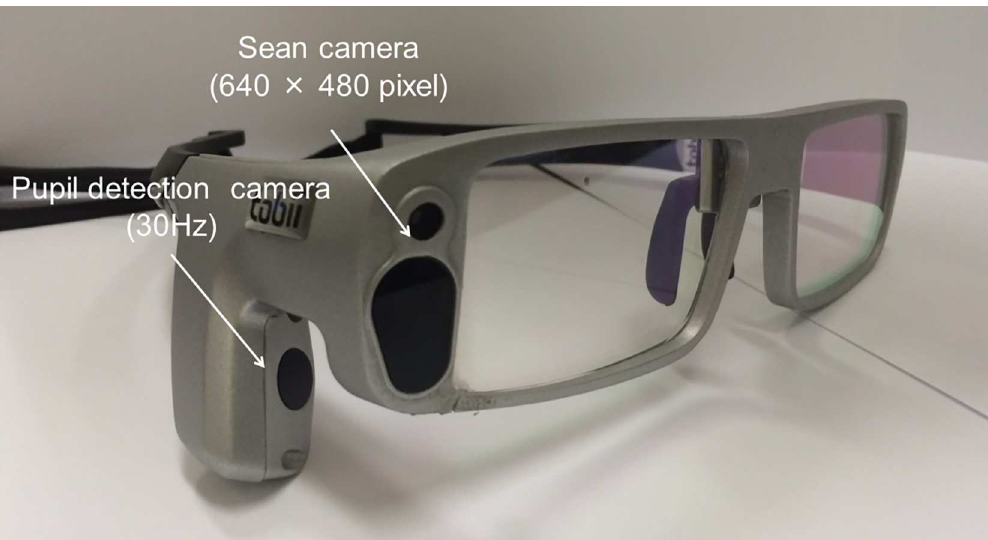
Fig 3. Schematic of Tobii Glass I. The wearable eye-tracking glasses consist of a camera with a resolutionof 640 × 480pixels mounted on the right temple, which records the eyesightof the participant; it also includesa pupil detectioncamera with a samplingfrequency of 30 Hz locatedon the right temple of the glasses for recordingthe participant’s